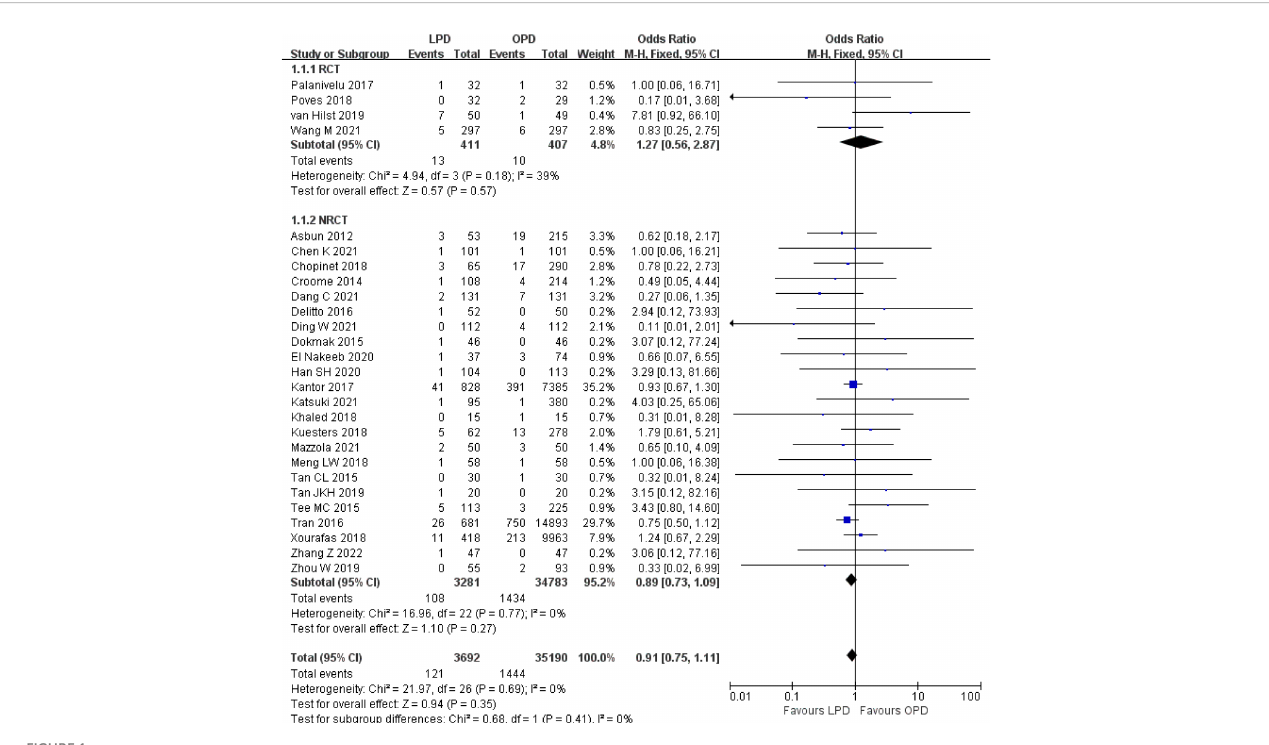
FIGURE 1 Forest plot of comparison between LPD and OPD on postoperative mortality. LPD, laparoscopic pancreaticoduodenectom; OPD, open pancreaticoduodenectomy.